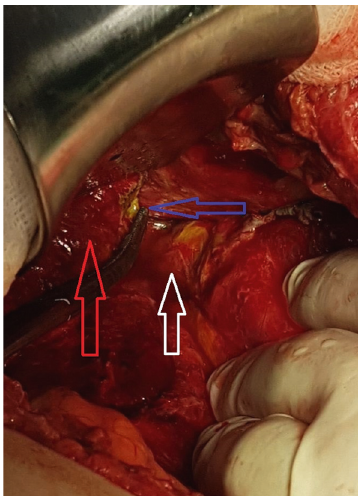
Figure 3: Left liver triangular ligament. Blue arrow shows bile leakage, red arrow shows the left triangular ligament, and white arrow shows the cardioesophageal